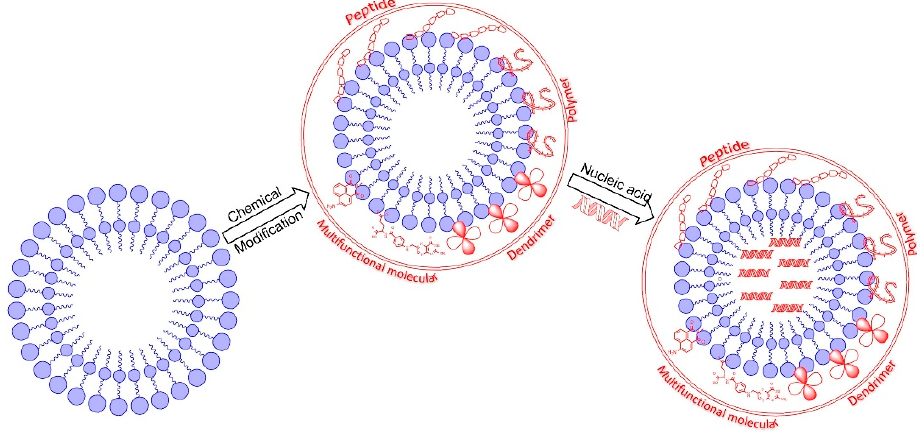
Figure 3. The structure of liposome nanoparticles modified with different chemical